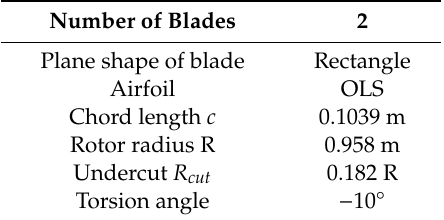
Table 2. Relevant parameters and flight status of AH-1G